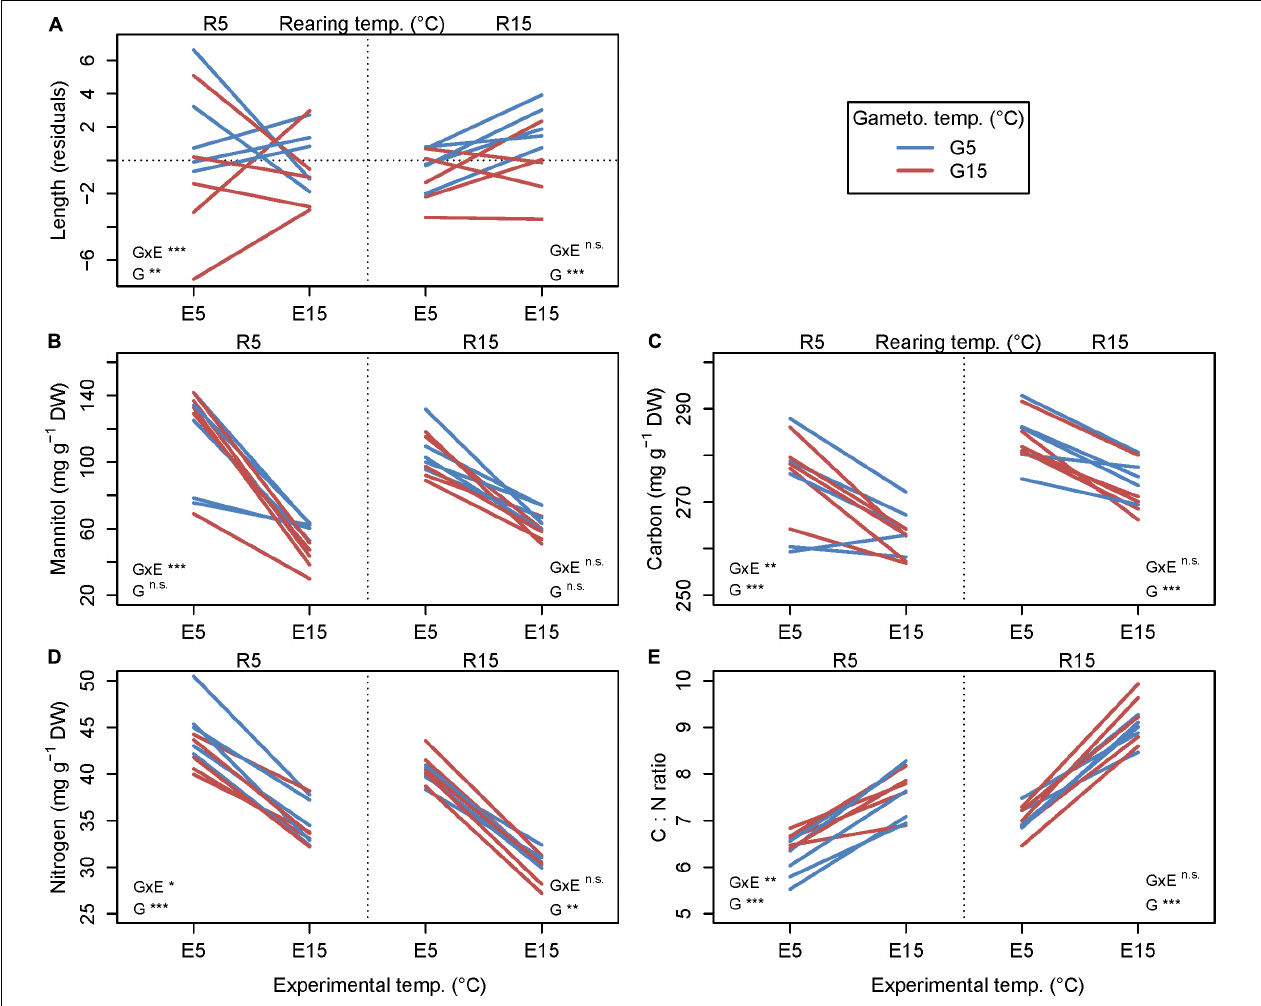
FIGURE 4 | Reaction norms of growth and biochemical parameters for each genetic line of Laminaria digitata in experiment 2 to visualize genetic variation for plasticity. Primary x-axis: experimental temperature, secondary x-axis: rearing temperature, slope colors: gametogenesis temperature. All plots show values obtained at the end of the 12-day experiment. (A) residual length growth, (B) mannitol contents in dry mass, (C) total carbon contents in dry mass, (D) total nitrogen contents in dry mass, (E) carbon to nitrogen mass ratio (C:N ratio). Means over single genetic lines, except for (B) means of mean values due to extraction in triplicates, n = 4. Statistical significance of the random factors for genetic line × experimental temperature interaction (GxE; random slope) and genetic line (G; random intercept) is summarized in the figure; *** p < 0.001; ** p < 0.01; * p < 0.05; n.s., not significant. For full statistical report see Table 3